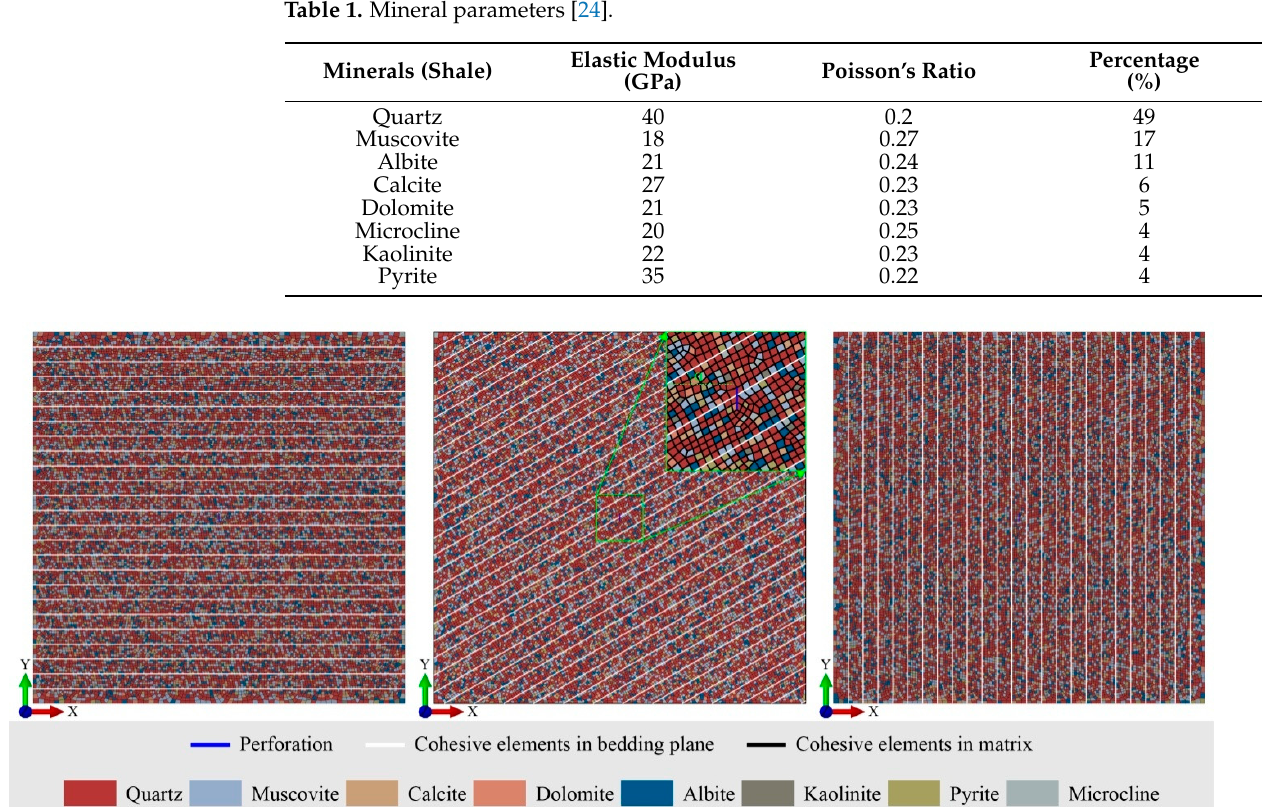
Figure 4. Numerical model of mineral heterogeneity. Different colors represent different minerals. The locations of individual minerals were determined randomly by the program. White represents cohesive elements in the BP, and black represents cohesive elements in the matrix. All cohesive elements had 0 thickness.